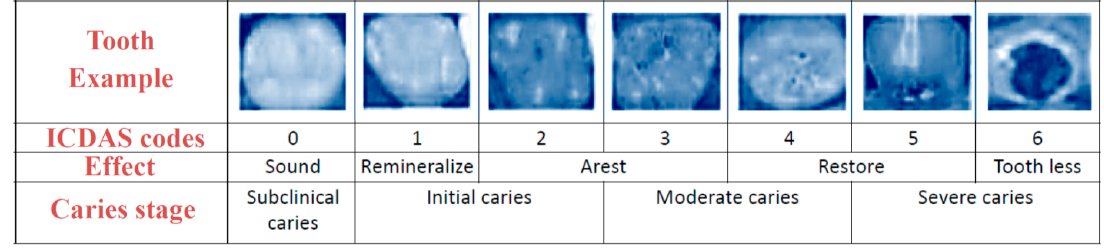
Figure 7. Scheme of the so-called caries continuum with codes from the ICDAS system.